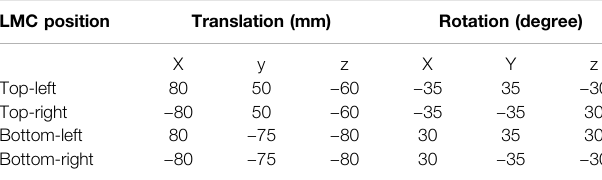
TABLE 1 | Design parameter for multi-LMC system.